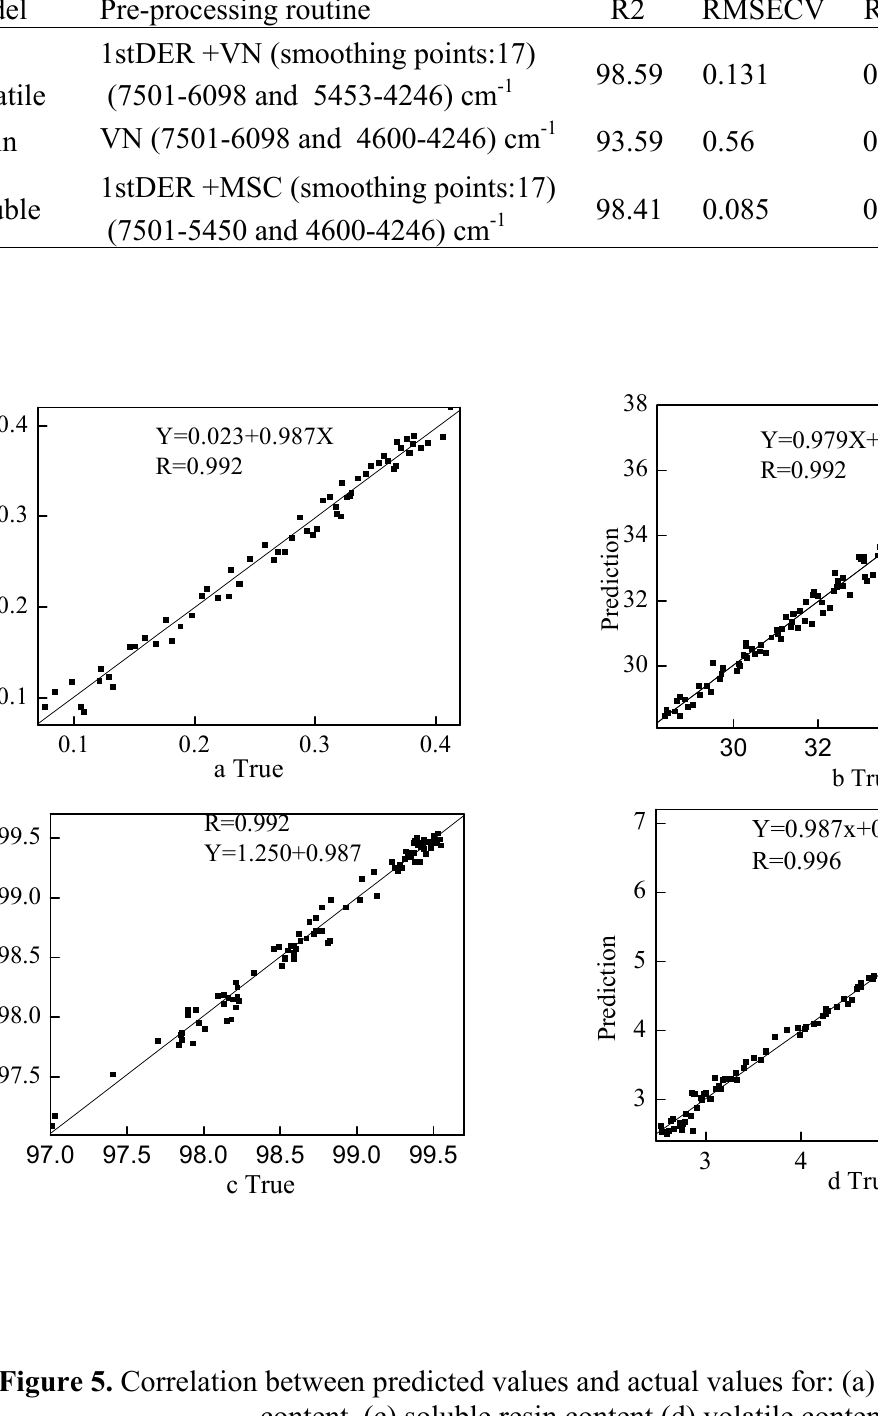
Figure 5. Correlation between predicted values and actual values for: (a) sizing content (b) resin content, (c) soluble resin content,(d) volatile